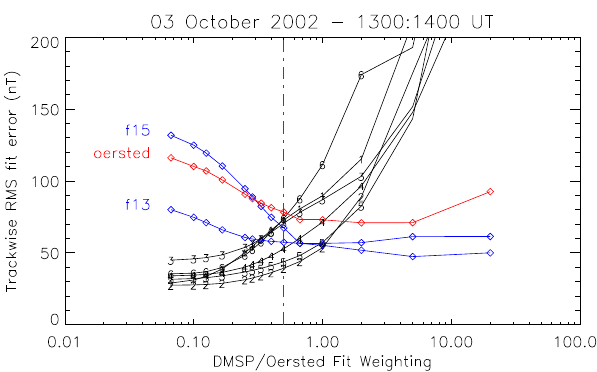
Fig. 2. Trackwise plot of the azimuthal fit error for all six Iridium tracks (black), two DMSP satellites (blue) and the Oersted satellite (red) as a function of the DMSP and Oersted data weighting factor. The green vertical line indicates the chosen weighting factor for this